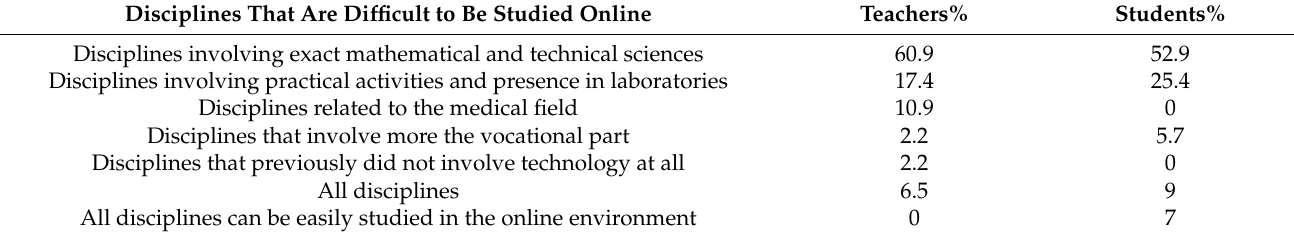
Table 11. Identifying the most difficult disciplines to be studied online from students’ and teachers’ perspective.